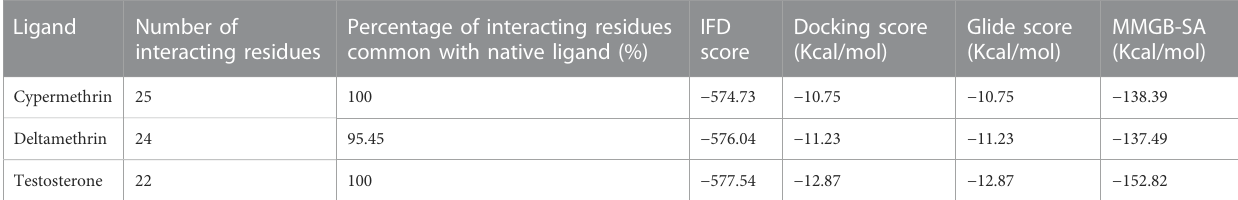
TABLE 1 Structural binding indices of class II pyrethroids, cypermethrin and deltamethrin, and AR native ligand, testosterone, against AR ligand-binding pocket. Ligand Number of Percentage of interacting residues interacting residues common with native ligand